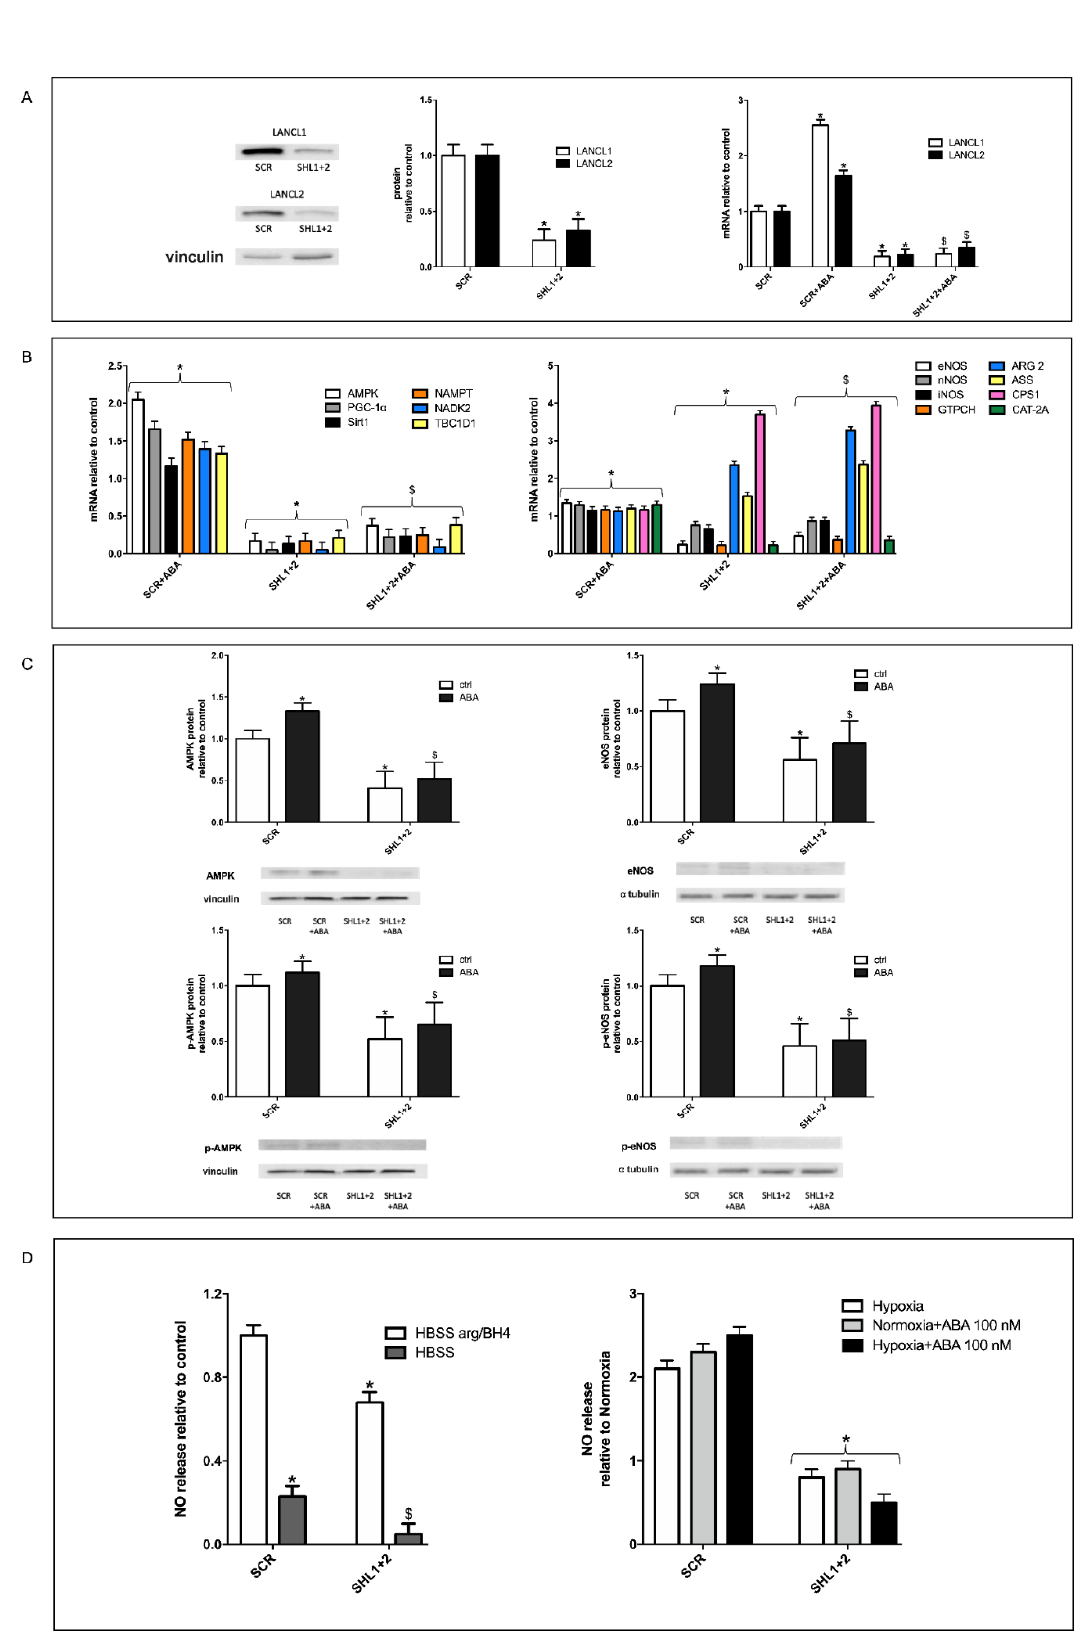
Figure 3. The double silencing of LANCL1 and LANCL2 reduces eNOS transcription, expression and function in H9c2 under normoxia and hypoxia. Stable silencing of both LANCL1 and LANCL2 in H9c2 cardiomyocytes was obtained by lentiviral infection of H9c2 cardiomyocytes with vectors containing the scrambled (SCR) or the LANCL1/2-specific (SHL1+2) silencing sequences ( A ). Transcription of putative target genes of the ABA-LANCL1/2 system ( B ), expression and